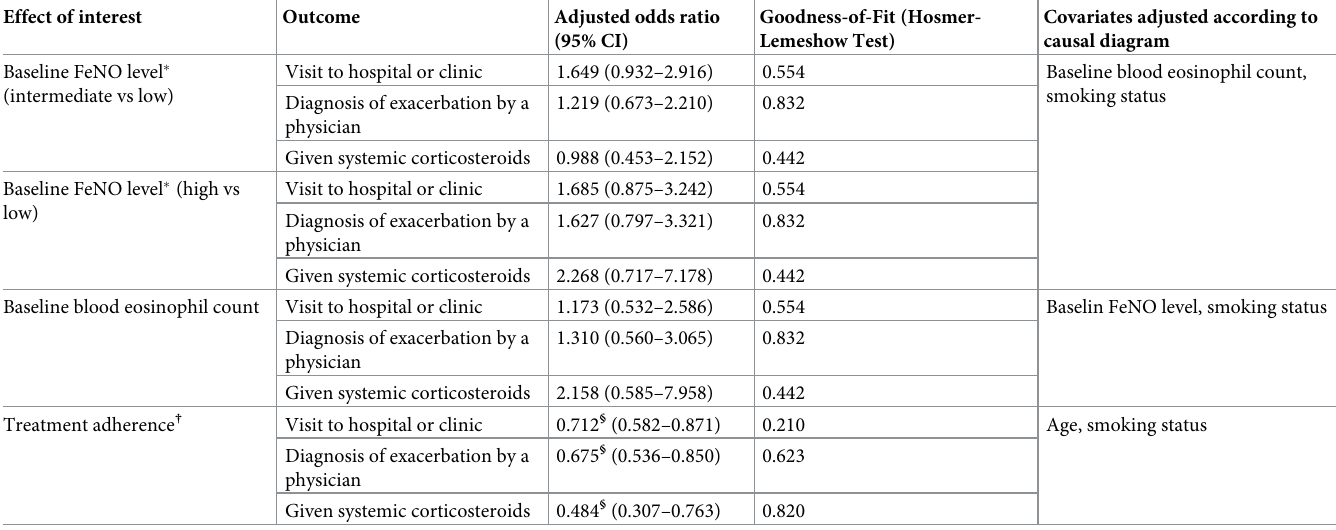
Table 2. Logistic regression models of risk of developing exacerbations.